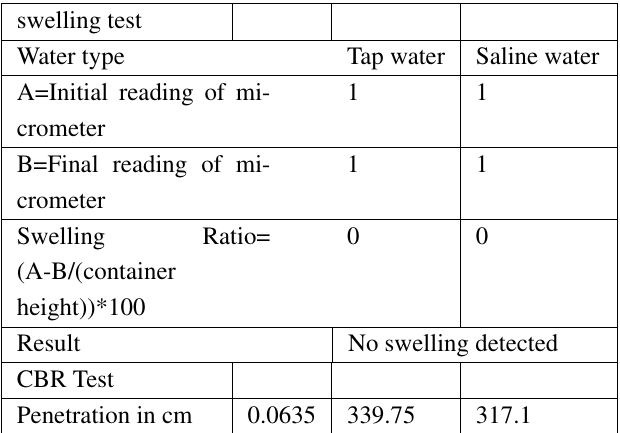
Table 4. CBR test results for samples containing saline water and tap